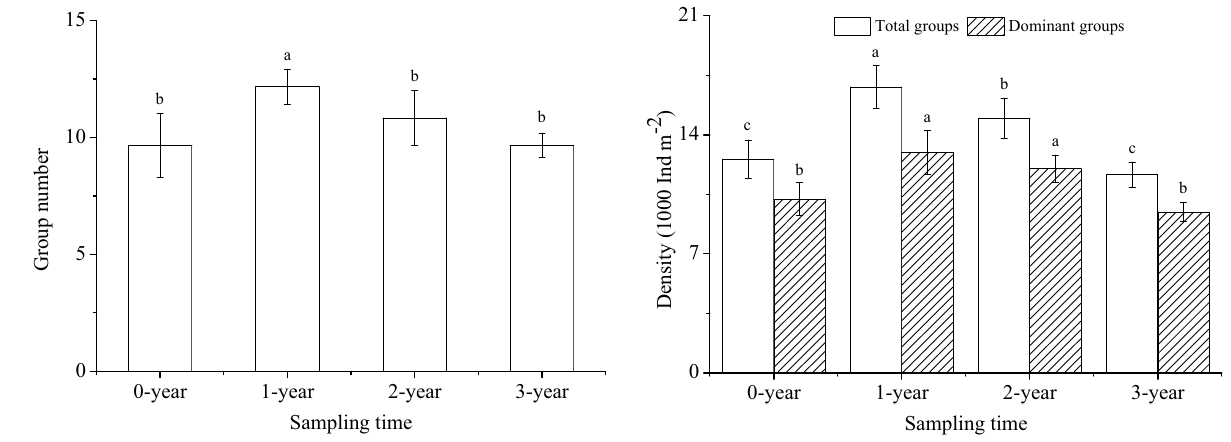
Figure 1. Group number and density of soil meso- and micro-fauna in different sampling times. 0-year, 1-year, 2-year and 3-year represent before planting, planting for one year, two years and three years, respectively. Different lowercase letters indicate significant differences among different sampling times ( P <